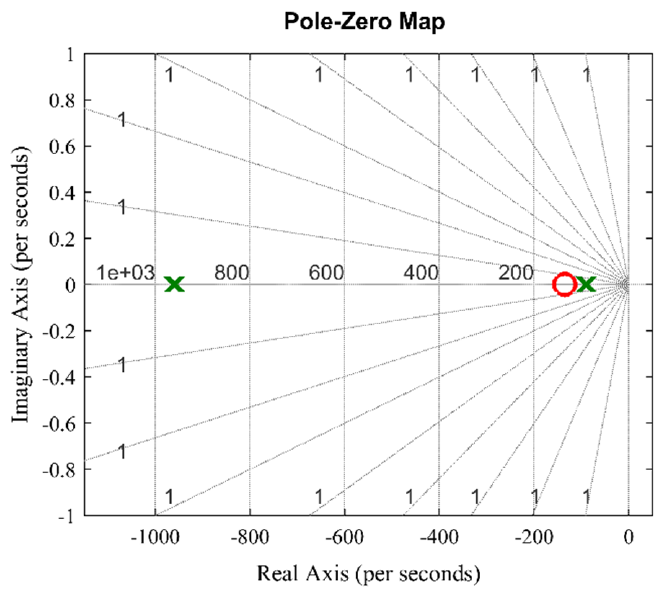
Figure 6. Pole-zero plot of closed-loop transfer function of d − axis current controller. The same implementation was also applied on the axis, where the slip was held at a value that ensured that the q –axis rotor flux was zero. The closed-loop transfer function for the axis current controller is shown in Figure 7.